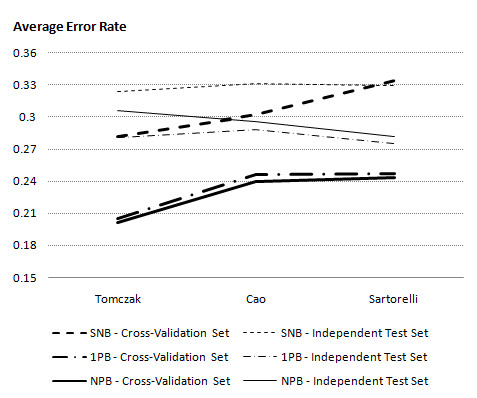
The comparison of classifiers with increasing model complexity. Three Bayesian network models (SNB, 1PB, and NPB) have been trained using cross-validation set and validated on independent datasets. An average error rate of the classifiers' prediction has been calculated for each gene and an overall SSE on cross-validation set and independent test set are illustrated in this figure.